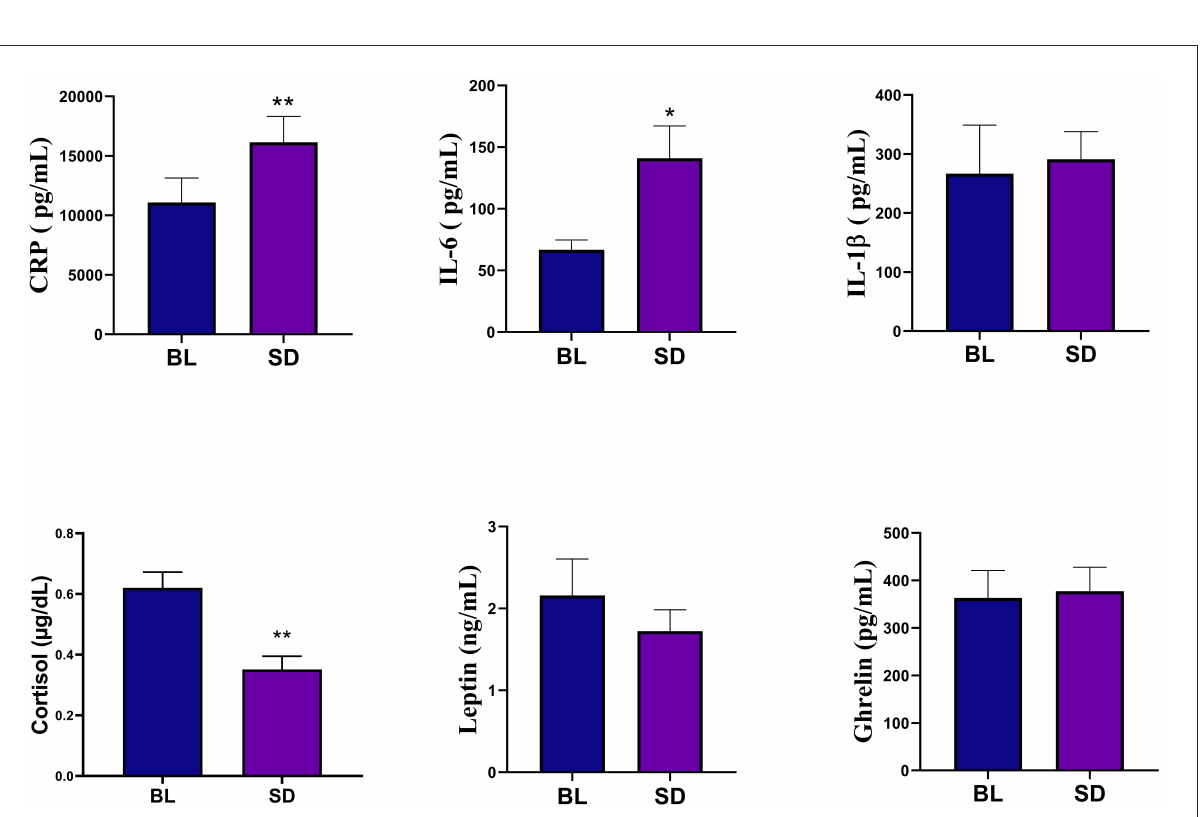
FIGURE2 Biomarker analyses showed that compared to baseline (BL), the sleep deprivation (SD) condition significantly increased in C-Reactive Protein (CRP) and IL-6. There was also a significant decrease in cortisol levels. Errors bars represent SEM and asterisks indicate p <